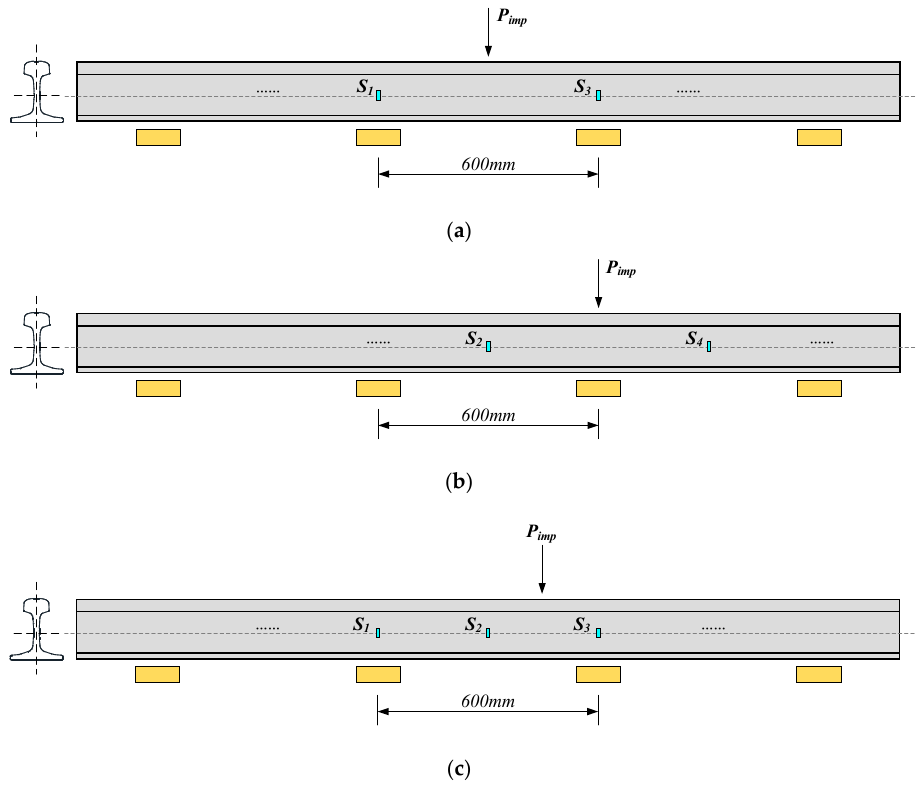
Figure 11. Plans of sensor arrangement: ( a ) Plan I, sensors are located above sleepers and intervals are 600 mm; ( b ) Plan II, sensors are located in the middle of the sleeper spacing and intervals are 600 mm; and ( c ) Plan III, sensors are evenly located along the rail and intervals are 300